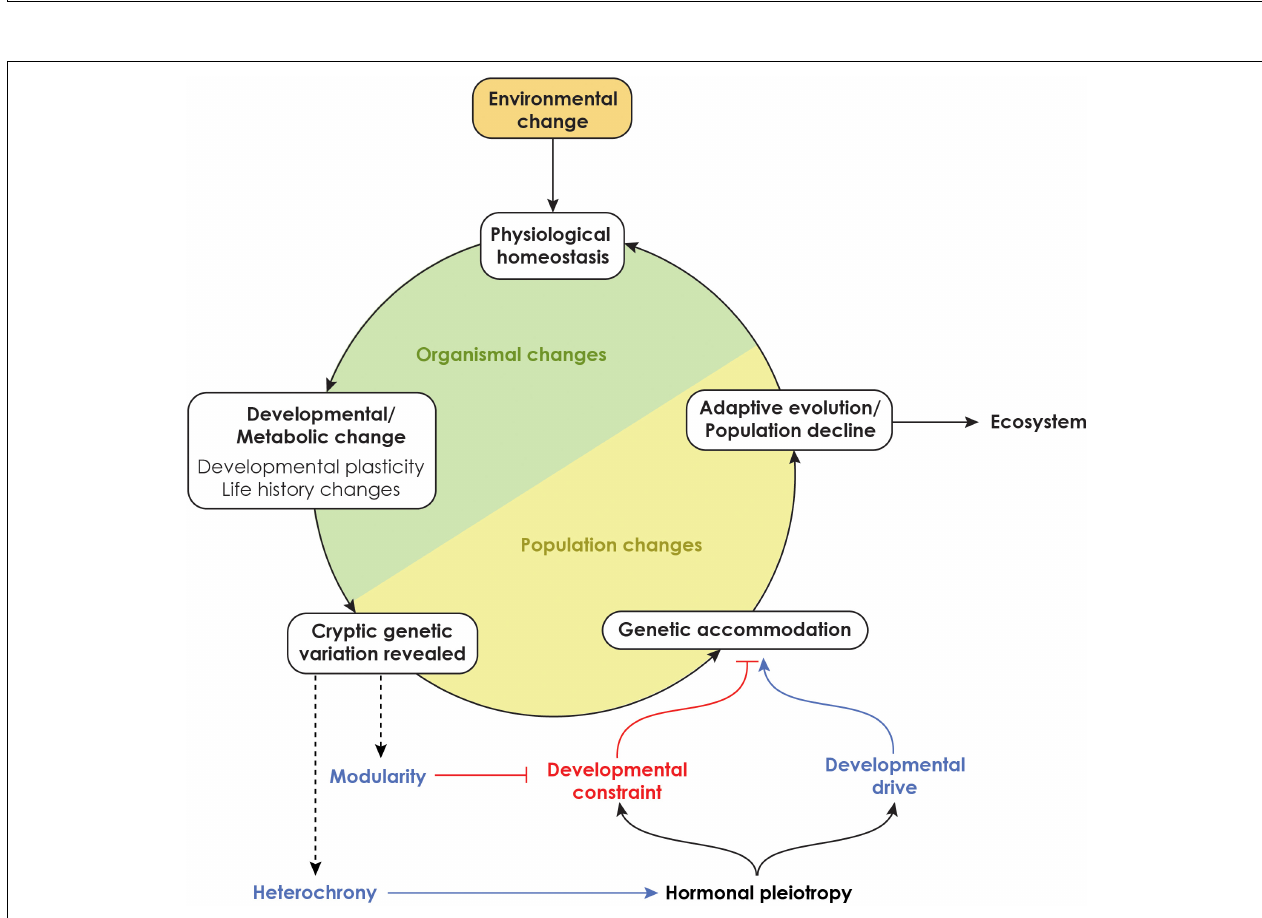
FIGURE 8 | Impact of climate change on developmental hormones and their ultimate impacts on populations and the ecosystem. Climate change can impact developmental physiology of organisms that can influence their development and life history. Cryptic genetic variation that is revealed as a consequence of climate change can fuel genetic accommodation of traits. The degree to which members of a population can adjust their development and physiology determines whether a population thrives or declines.